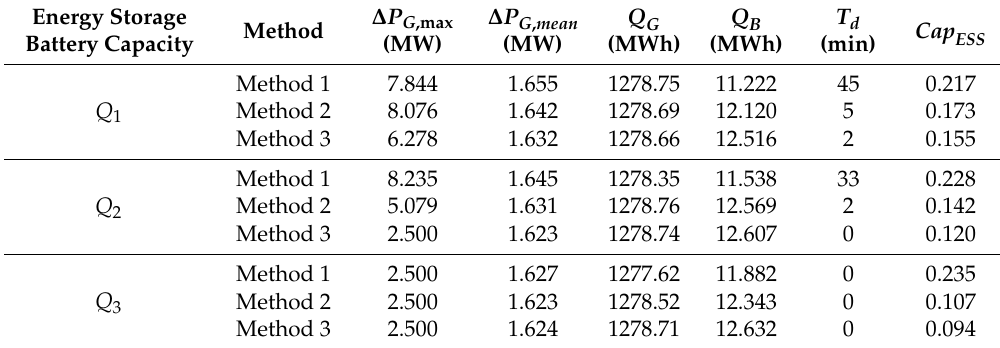
Figure 11. Frequency distribution histograms of different energy storage SOE intervals under different δ during a typical day. Table 4. Assessment criteria under different Q. Table 5. Assessment criteria under different δ .